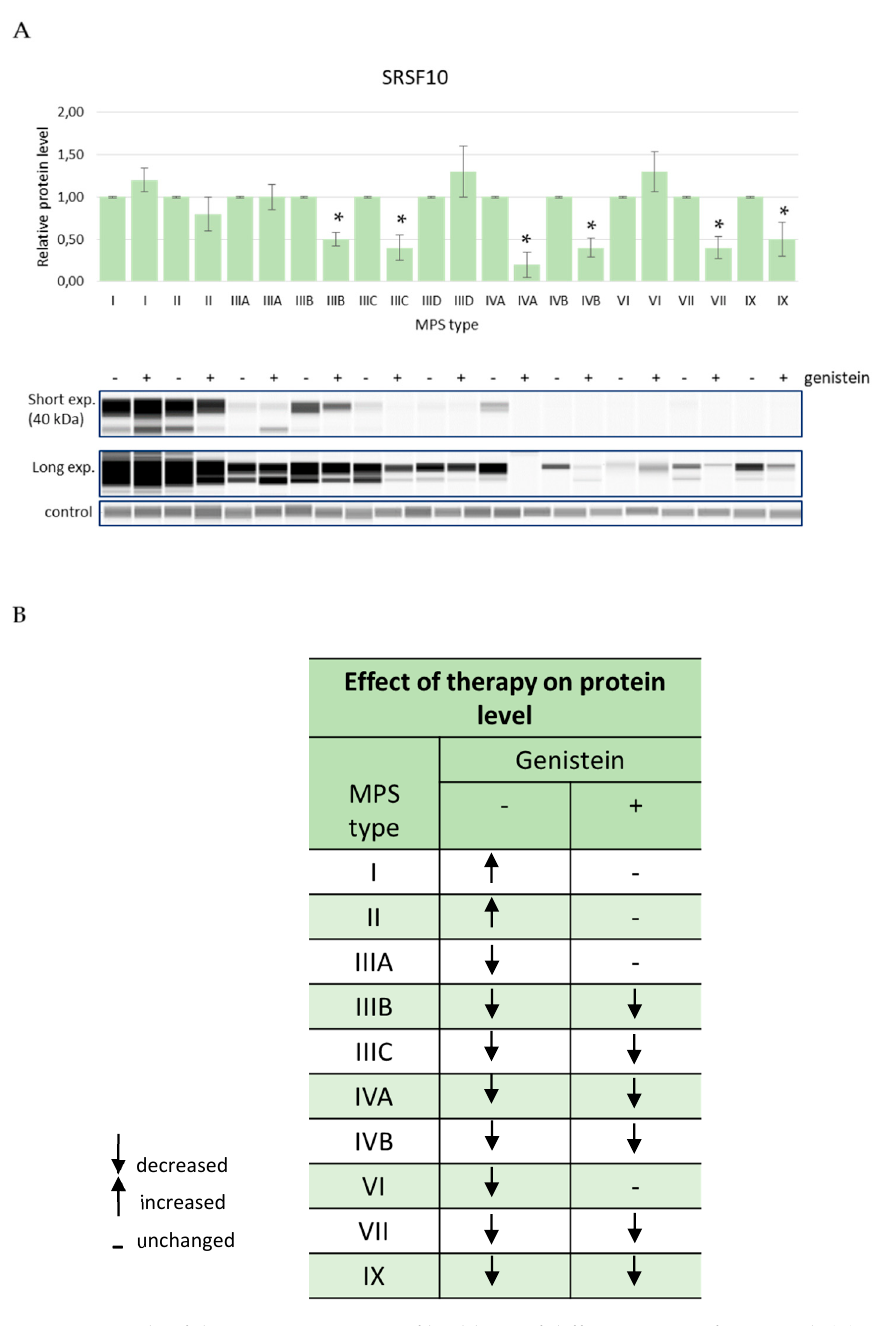
Figure 7. Levels of the SRSF10 protein in fibroblasts of different types of MPS with (+) and without ( − ) treatment with 50 µ M genistein for 48 h (only MPS types which revealed significantly changed amounts of this protein relative to HDFa control cells (see Figure 4) are shown). Panel ( A ) shows representative blots and the quantification of the results by densitometry, where value 1 corresponds to the level of SRSF10 determined in MPS cells not treated with genistein. Panel ( B ) shows the scheme of results where the column ( − ) indicates the levels of SRSF10 in MPS cells relative to HDFa control while the column (+) indicates the levels of this protein in cells of the corresponding MPS types after 48 h of treatment with 50 µ M genistein relative to untreated MPS cells. Up-headed arrows indicate increased levels, down-headed arrows indicate decreased levels, and dashes indicate no significant changes. In panel ( A ), the results indicated by the columns are mean values from three independent experiments with error bars representing SD. Statistically significant differences relative to the untreated MPS cells ( p < 0.05) are indicated by asterisks (*).